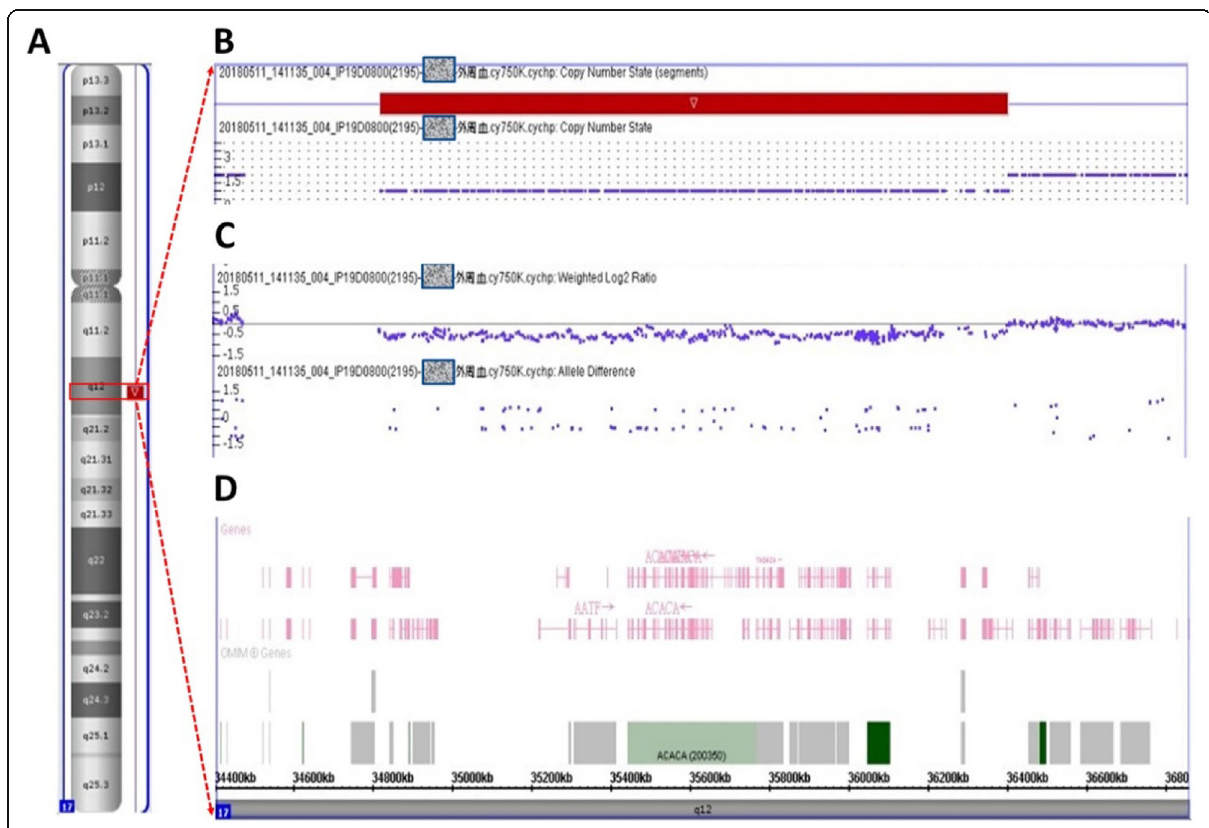
Fig. 1 Molecular karyotyping revealed a deletion of approximately 1.58-Mb in Chr17q12 in patients. a Chromosome ideogram. The deletion region is highlighted in red. b Cytoscan high-density array identified a 1.58-Mb region (34,822,465-36,404,104) of hemizygous loss. c Magnification of the hemizygous loss region. d Genes located in the 1.58-Mb hemizygous loss